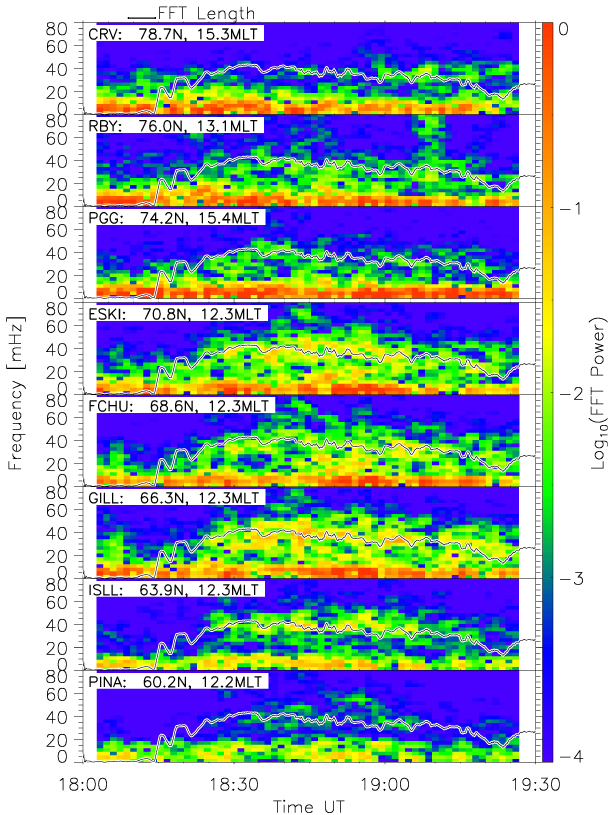
Fig. 8. Dynamic spectra of X component data from some ground based magnetometer stations belonging to the CARISMA and MACCS array in Canada on 5 September 2002. The station’s name, magnetic latitude and MLT are given in the top left corner of each panel. Also shown as a solid black line is the predicted frequency of the upstream generated waves as given by Eq.